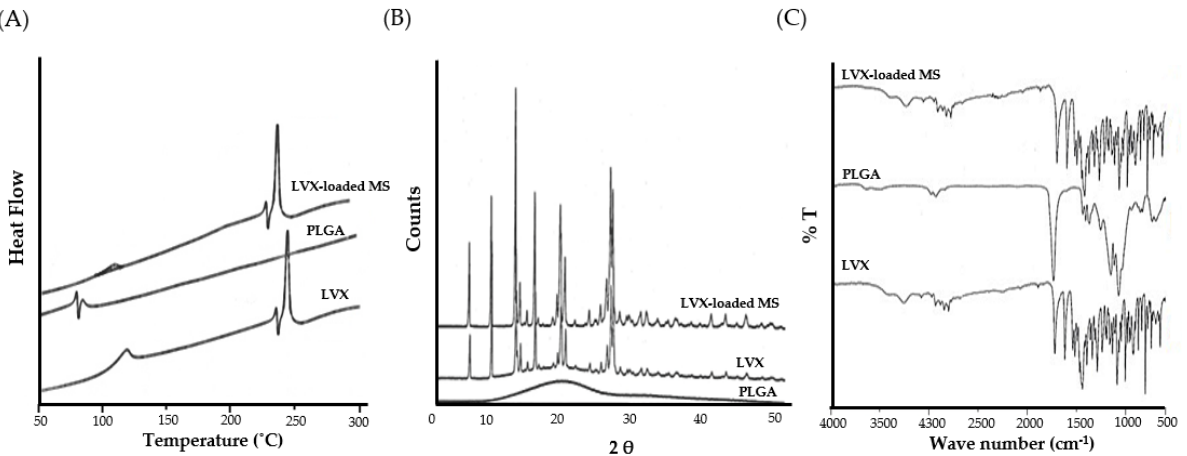
Figure 3. ( A ) DSC thermograms; ( B ) X-ray diffractograms; ( C ) FTIR spectra Pure LVX, PLGA polymer, and LVX-loaded microspheres.